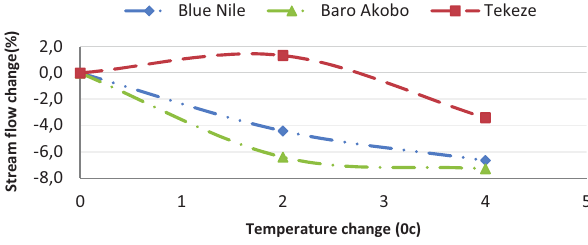
Fig. 9. Annual streamflow changes (%) to temperature change ( ◦ C) Figure 9: Annual streamflow changes (%) to temperature change (°C) holding precipitation holding precipitation fixed for the three fixed for the three basins.